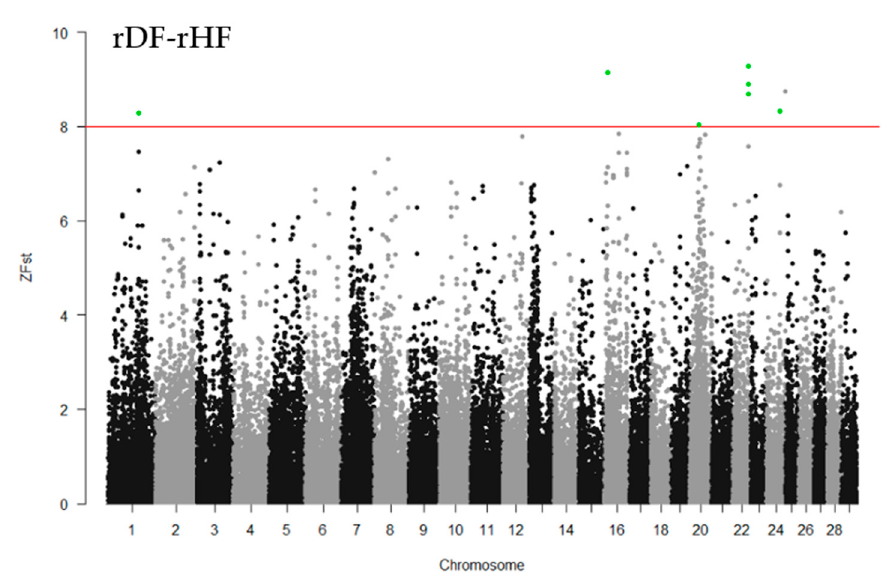
Figure 4. Manhattan plots of Z-transformed fixation index (ZFst) across all autosomes. The ZFst values were calculated for each sliding 40-kb window with steps of 20 kb across all autosomes. The solid red line indicates ZFst values > 8; differentiated genomic regions (ZFst values > 8 and the number of SNPs in the region > 5) are highlight green.